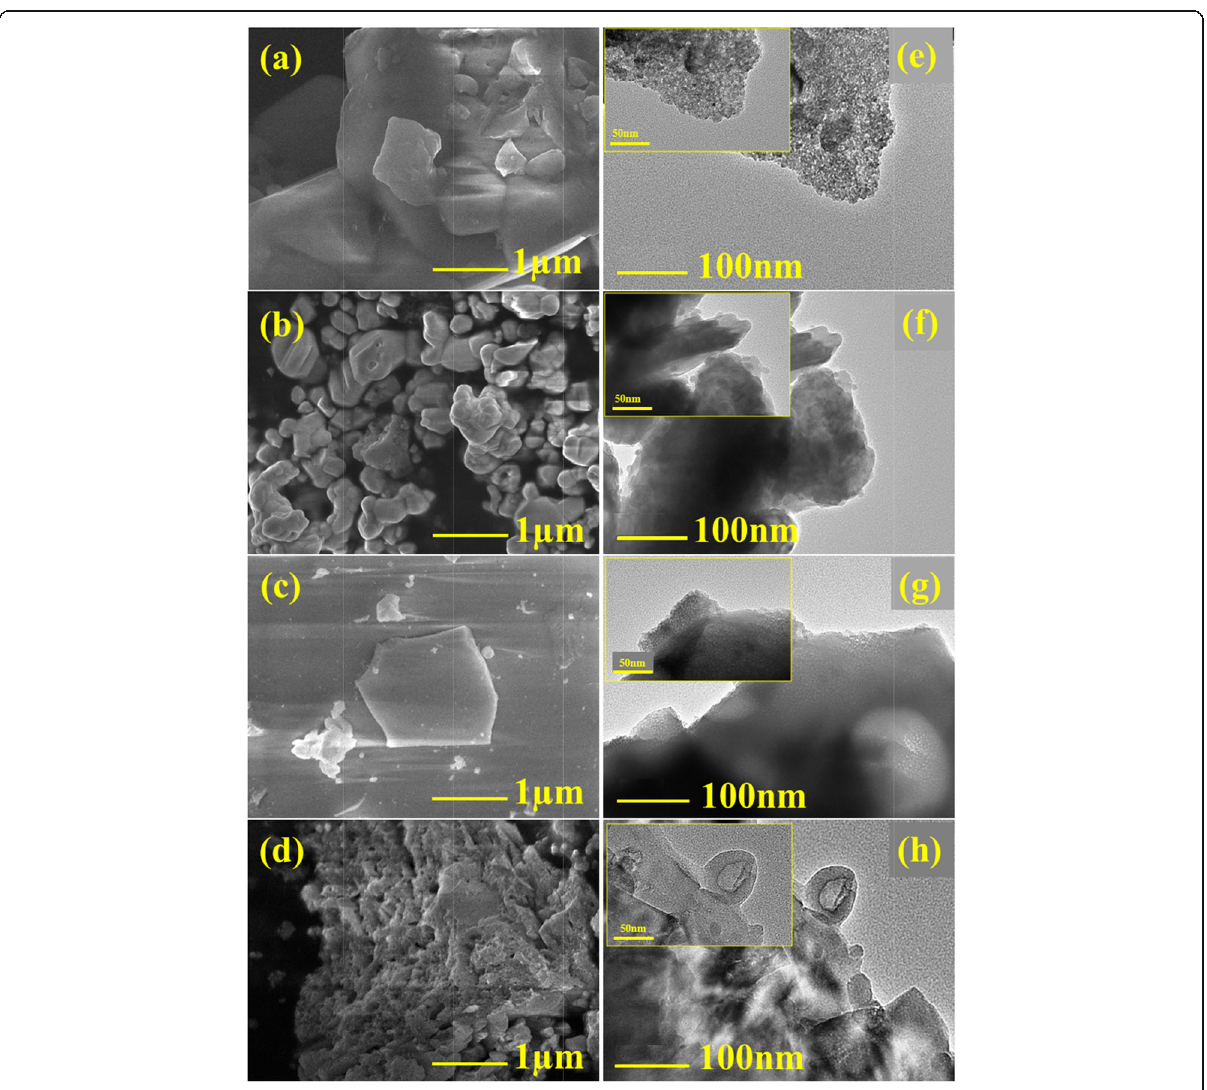
Fig. 4 a-d FESEM in micrometer scale. e-h Low magnification HRTEM micrographs of C1, C2, C3, and C4 NPs with high magnification